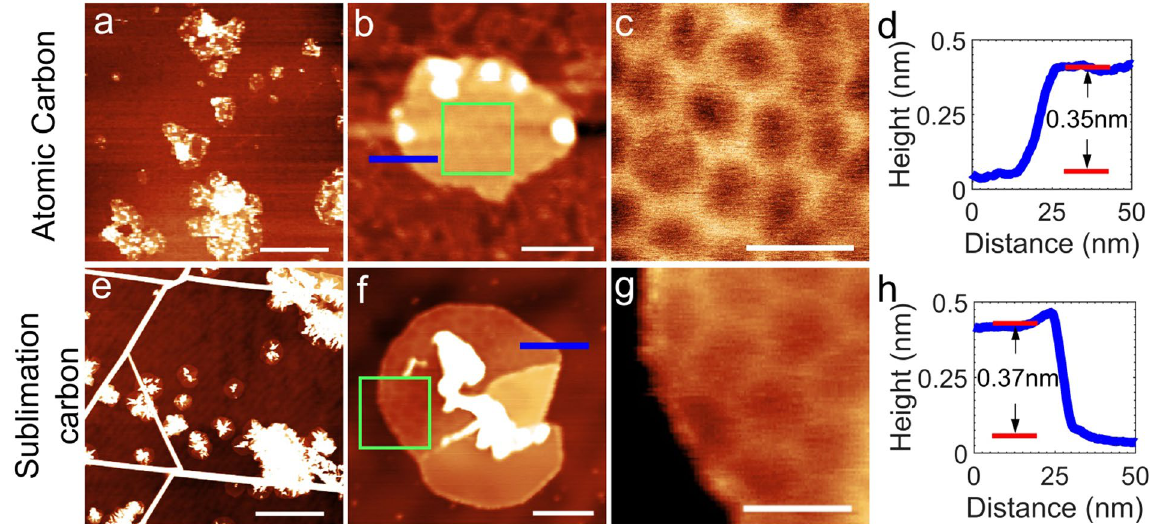
Figure 2. AFM topography images showing the early stages of graphene island nucleation on hBN at a substrate temperature of 1400 °C. Images ( a – c ) show graphene islands grown for 5 h using the atomic carbon source and images ( e – g ) show graphene grown for 1 h with a carbon sublimation source. Images ( c and g ) show the region highlighted by the green boxes in images ( b and f ) respectively. The profiles in images ( d and h ) show a line profile across the positions indicated by the blue line in figs ( b and f ) respectively. The scale bars for the images are as follows; ( a and e ) 500 nm, ( b and f ) 50 nm, ( c and g ) 20